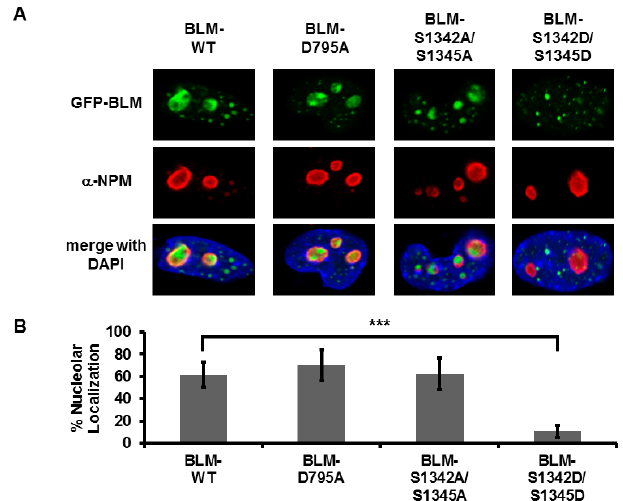
Figure 4. S1342 and S1345 determine nucleolar localization of BLM. ( A ) Cellular localization of BLM phospho ‐ dead (BLM ‐ S1342A/S1345A) and phospho ‐ mimetic (BLM ‐ S1342D/S1345D) mutants. GM08505 BLM − / − cells were plated on sterile coverslips and transfected with the indicated